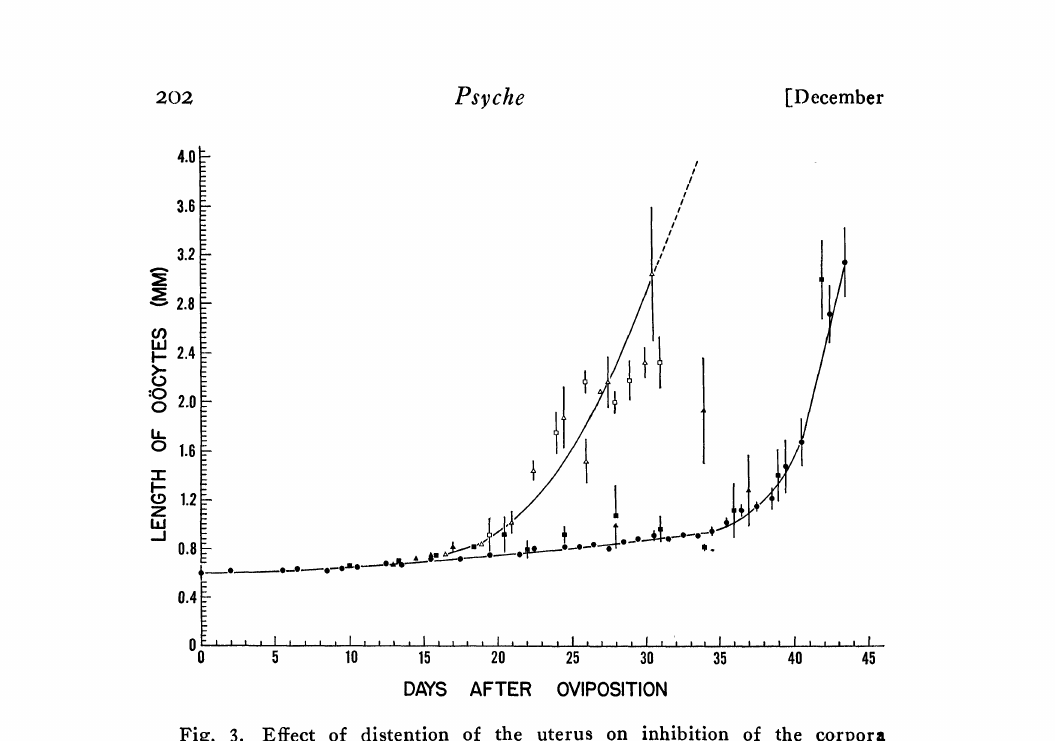
Fig. 3. Effect of distention of the uterus on inhibition of the corpora cinerea. allata during early gestation in N. Solid circles Carrying o6thecae (controls). Five to 18 females per point (N 276). Open squares o/Sthe- cae removed <24 hr. after ovipositing; no glass tube inserted in uteri.,Five 65). Solid squares O6thecae removed <24 hr. after ovipos,iting, glass tube (3-3.5 mm. 10-11 mm.) inserted in uteri. Four to 10 females per point (N 99). Open triangles 65). Solid